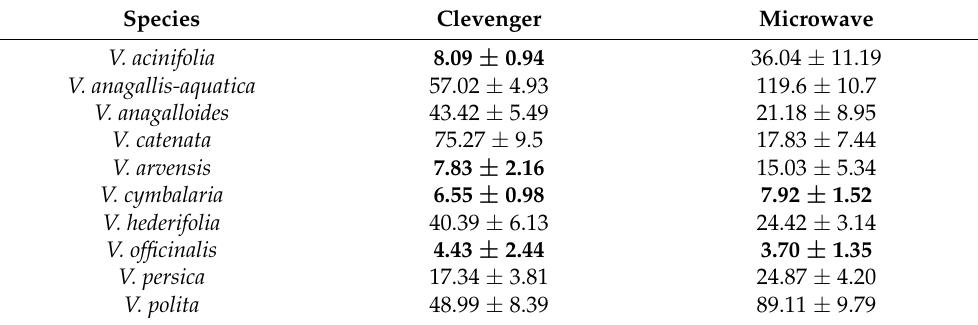
Table 4. Antioxidant potential determined by DPPH method of the hydrosols obtained by Clevenger and microwave-assisted extraction from the aerial parts of 10 Veronica